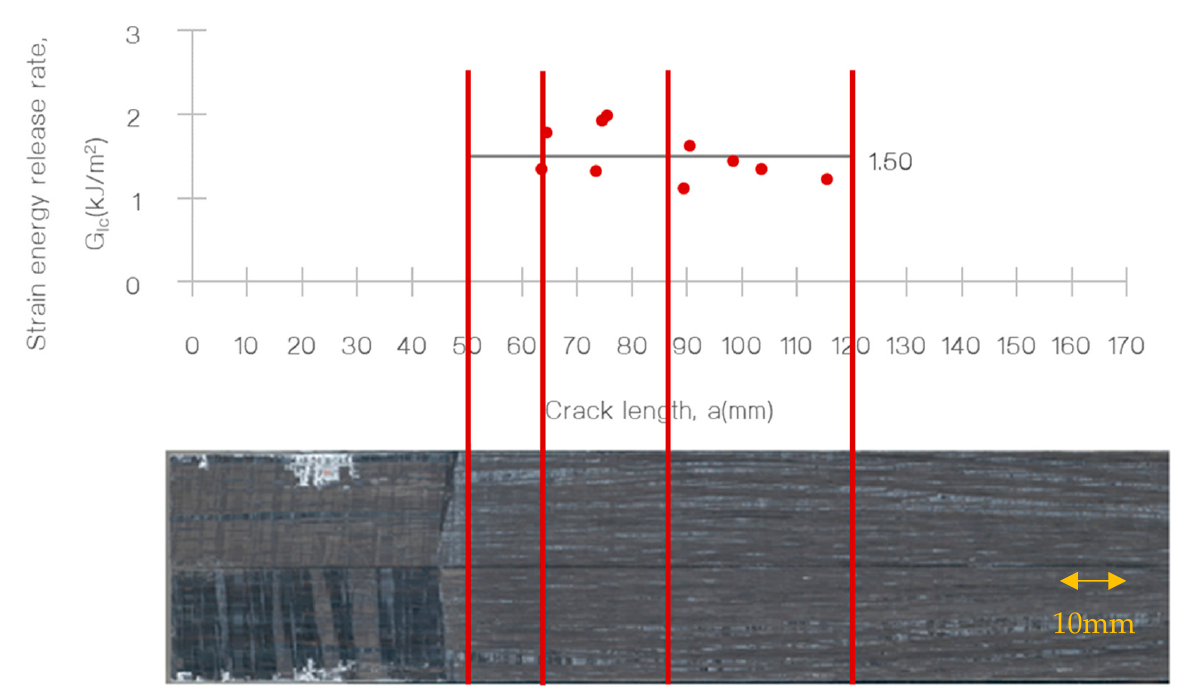
Figure 6. Delamination resistance curve (R-curve) from the DCB test of the T700/PPS system.